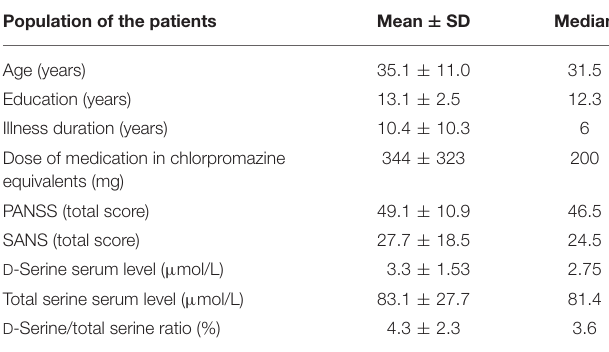
TABLE 2 | Population of the patients: demographical data, the results of clinical assessments, and amino acid serum levels ( n = 50; males, n = 33; females, n =